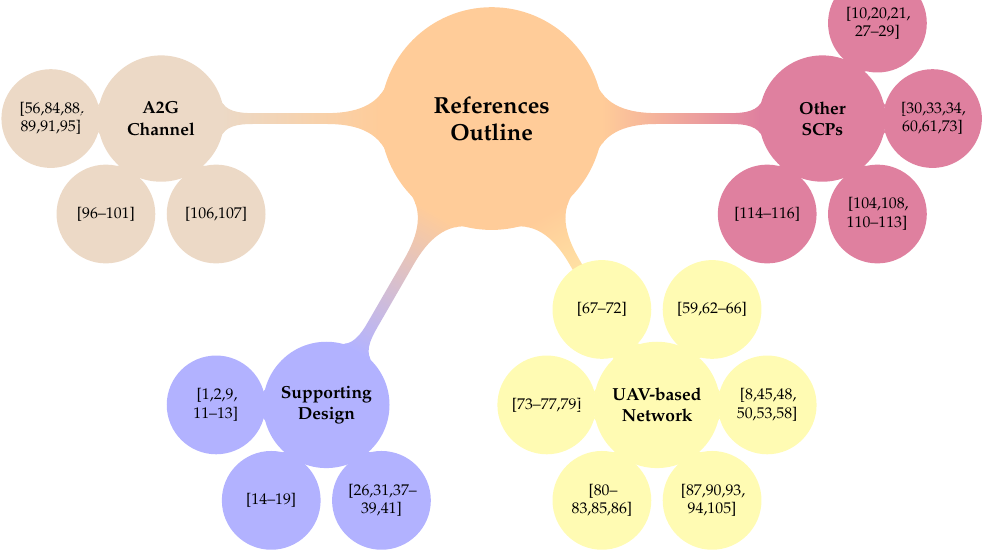
Figure 2. Some Used references in our